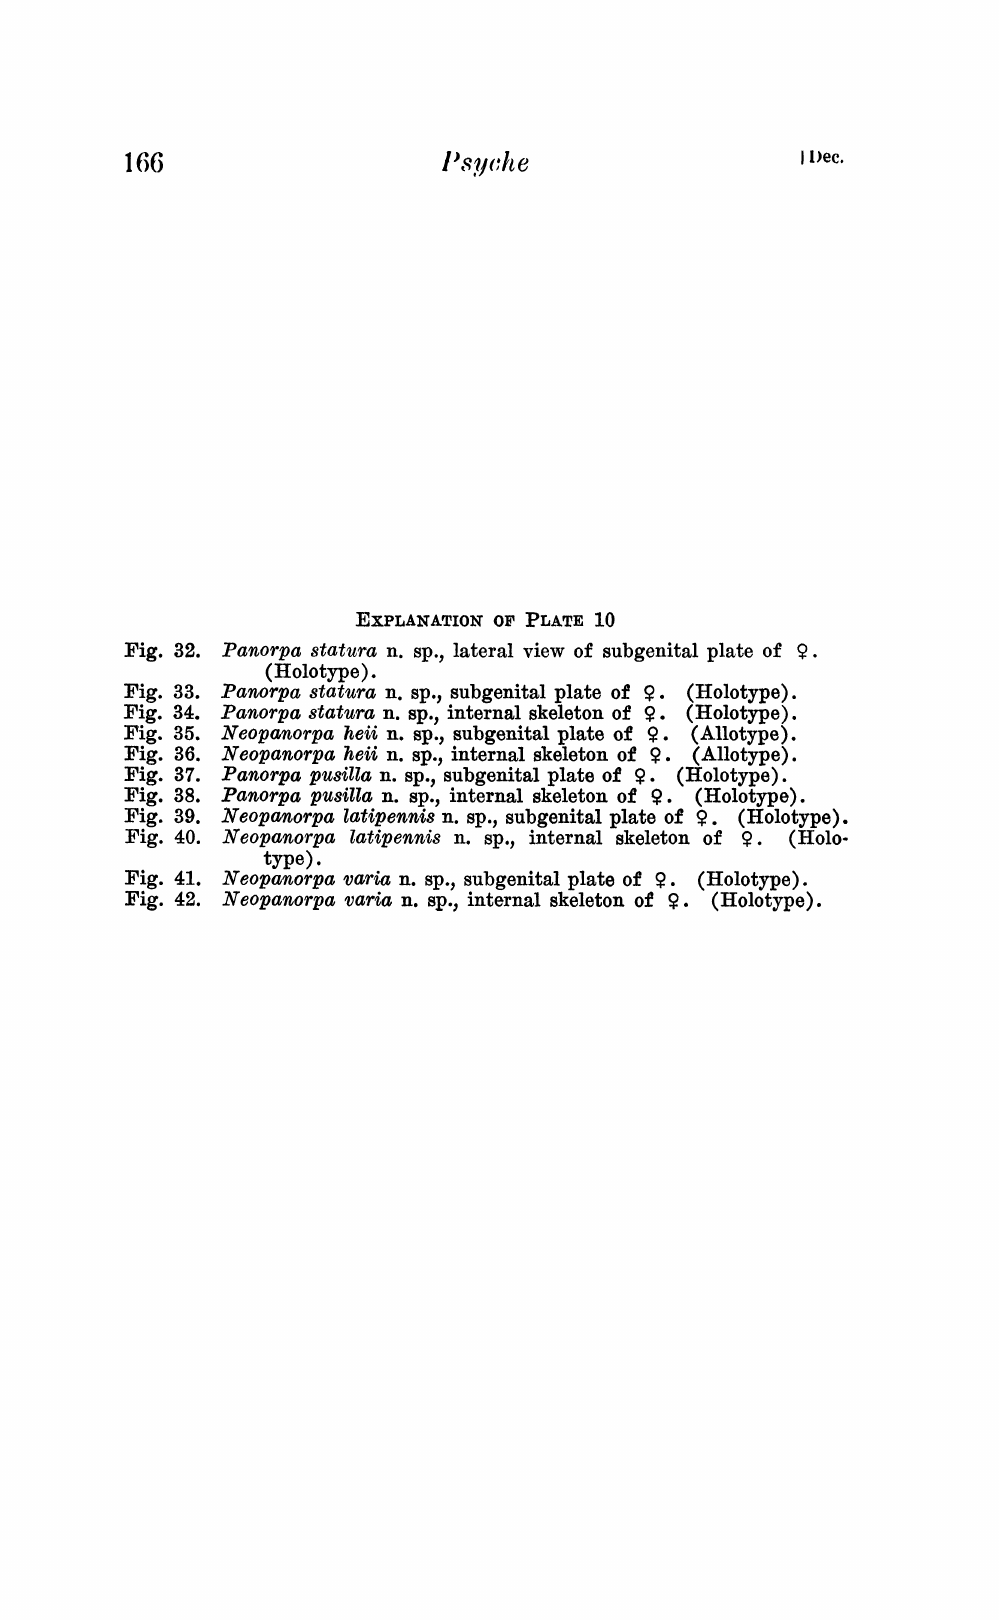
Panorpa statura n. sp., lateral view of subgenital plate of